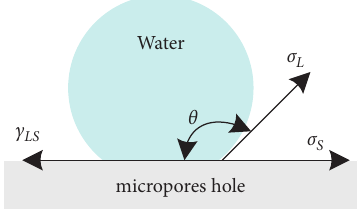
Figure 2: A microforce balance between nonwetting liquid and solid surface.